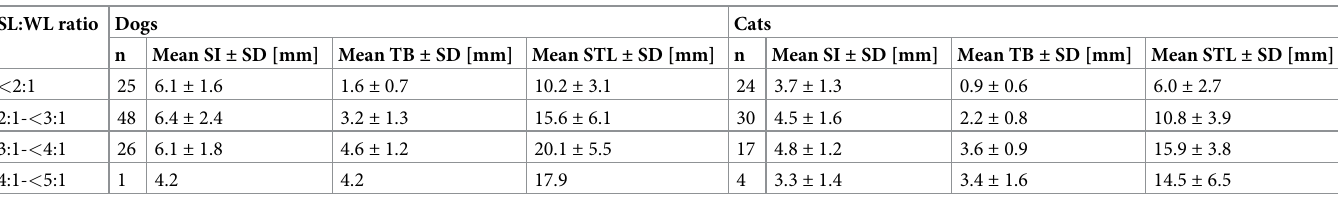
n = number of sutures, Mean SI = mean stitch interval, Mean TB = mean tissue bite, Mean STL = mean stitch length, SD = standard deviation, SL:WL ratio = suture length to wound length